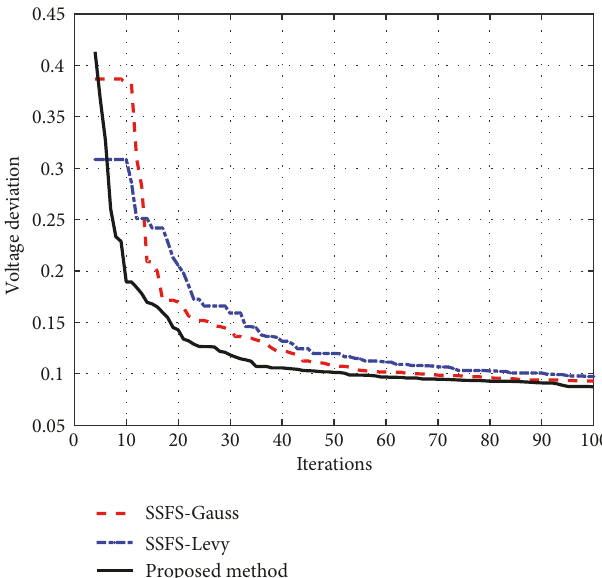
Figure 8: The best run obtained by three methods for voltage deviation optimization of IEEE 30-bus system.